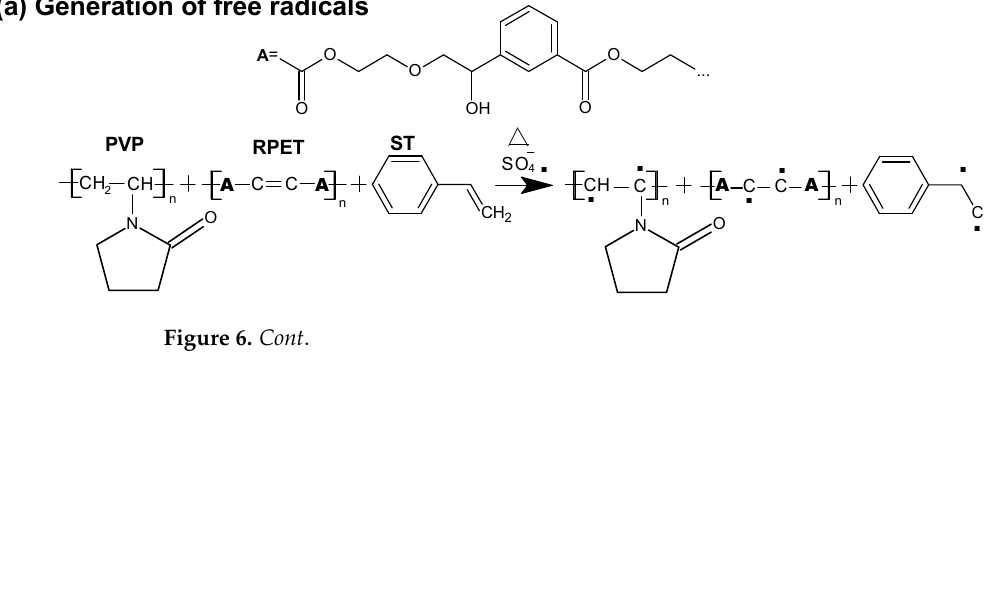
Chemical bonding Figure 6. Mechanism of the reaction of nanofibers: ( a ) Generation of free radicals, ( b , c ) semidevel- oped chemical interactions, and ( d , e ) schematic representations of composite nanofibers. 4. Conclusions This study demonstrated the production of a new type of nanofiber from recycled PET and the preparation of RPET/PVP nanofibers without defects and with an average diameter of 300–400 nm with enhanced mechanical properties that were more than 10